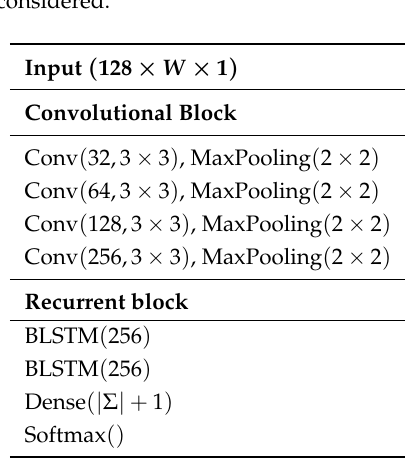
Table 3. Instantiation of the CRNN used in this work, consisting of 4 convolutional layers and 2 recurrent layers. Notation: Input ( h × w × c ) means an input image of height h , width w and c channels; Conv ( n , h × w ) denotes a convolution operator of n filters and kernel size of h × w ; MaxPooling ( h × w ) represents a down-sampling operation of the dominating value within a window of size ( h × w ) ; BLSTM(n) means a bi-directional Long Short-Term Memory unit of n neurons; Dense(n) denotes a dense layer of n neurons; and Softmax() represents the softmax activation function. Σ denotes the alphabet of musical symbols